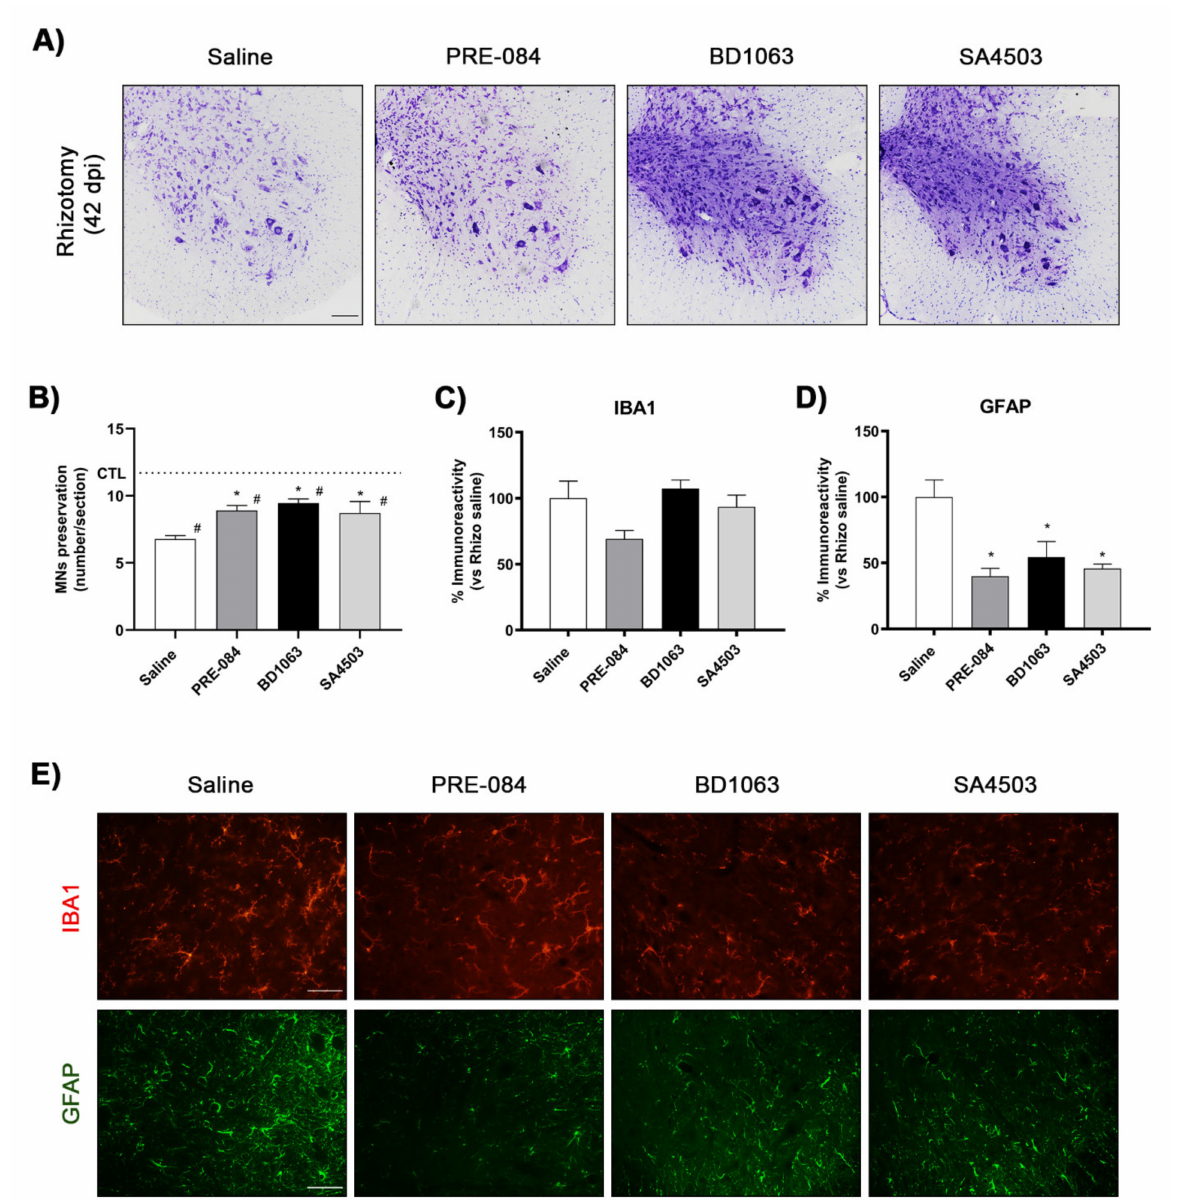
Figure 3. Administration of Sig-1R ligands promotes MN preservation after rhizotomy. ( A ) Representative images of ventral horns of L4–L5 spinal segments ipsilateral to rhizotomy in female mice with or without Sig-1R ligand treatment at 42 dpi. Cresyl violet stain. Scale bar 100 µ m. ( B ) Plot of numbers of surviving α -MNs in L4–L5 segments, showing higher numbers of MNs in mice treated with Sig-1R ligands PRE-084, BD1063 and SA4503. Animals per group at 42 dpi: saline n = 11, PRE-084 n = 4, BD1063 = 4 and SA4503 n = 4. Data are mean ± SEM and analyzed with One-way ANOVA and Bonferroni multiple comparisons test. * p < 0.05 vs. saline rhizotomy mice at same time-point; # p < 0.05 vs. control mice. ( C , D ) Plots showing the percentage of immunoreactivity of Iba-1 ( C ) and GFAP ( D ) in the ipsilateral ventral horn of the spinal cord after rhizotomy and treatment with Sig-1R ligands. Data are mean ± SEM and analyzed with One-way ANOVA and Bonferroni multiple comparisons test. * p < 0.05 vs. saline rhizotomy mice. ( E ) Representative images of immunolabeling of microglia (Iba1) and astrocytes (GFAP) in the ipsilateral ventral horn of rhizotomized mice at 42 dpi. Scale bar 50 µ